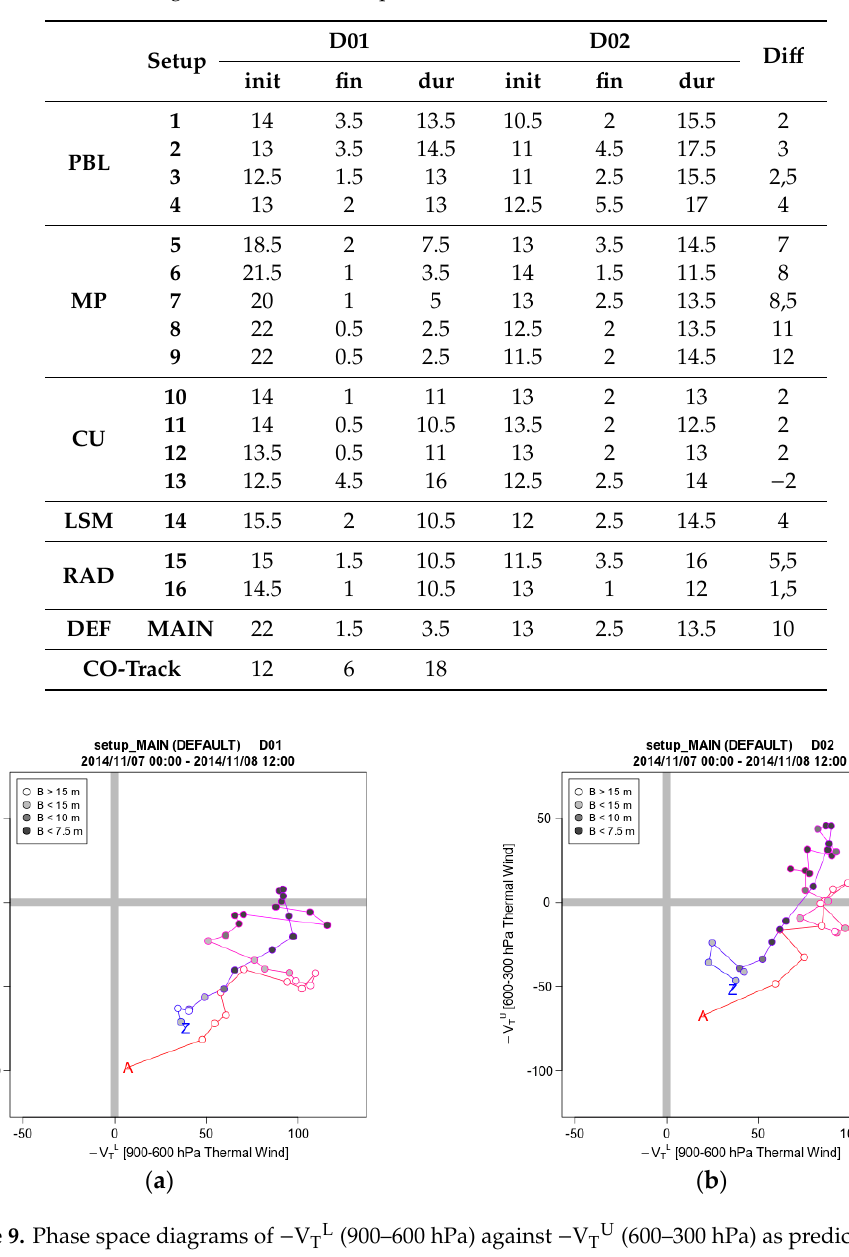
Table 3. Time of first and last occurrence of a deep symmetric warm-core as well as duration in all simulation experiments and in the ERA5 dataset according to the phase space diagrams. Init: initial occurrence in UTC time on November 7th, Fin: last occurrence in UTC time on November 8th, Dur: duration in hours, Di ff : di ff erence in duration between the D01 and D02 simulations for each model setup. All numbers are given with half hour precision.